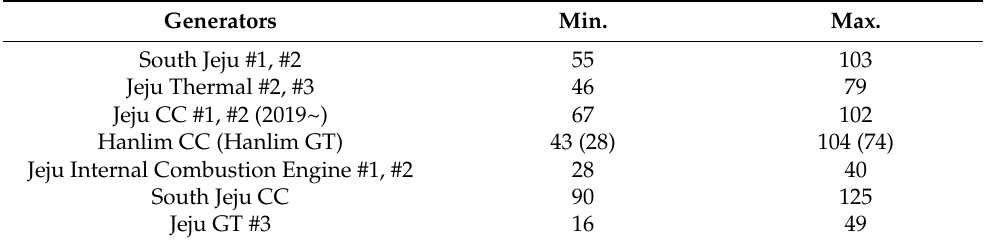
Table 7. The minimum and maximum of generation capacity of all conventional generators in Jeju. Generators